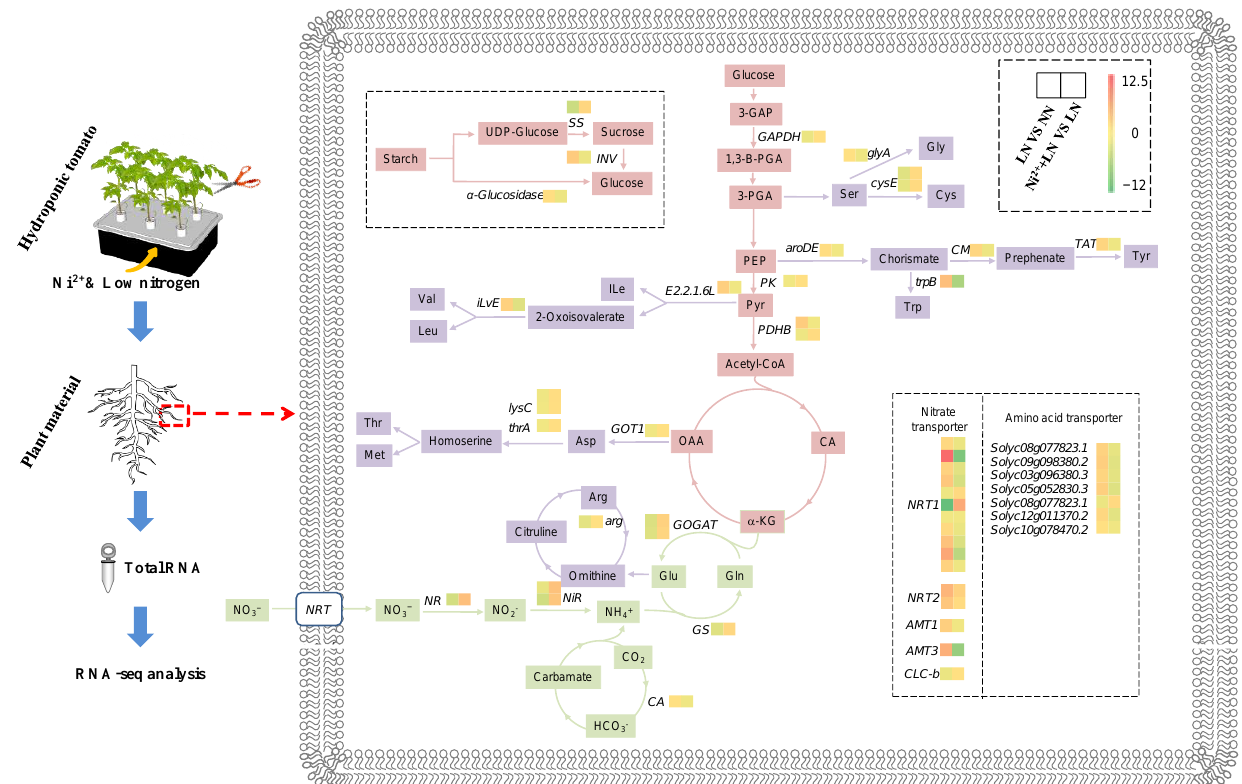
Figure 6. A simplified transcriptional map based on associated transcriptional pathways in tomato roots in response to Ni 2+ and LN levels. Each square represents DEGs, and the color indicates the log 2 (fold change) of the DEGs (|log 2 (fold change)| ≥ 1 and p -adjusted value < 0.01; red indicates upregulation, and green indicates downregulation).